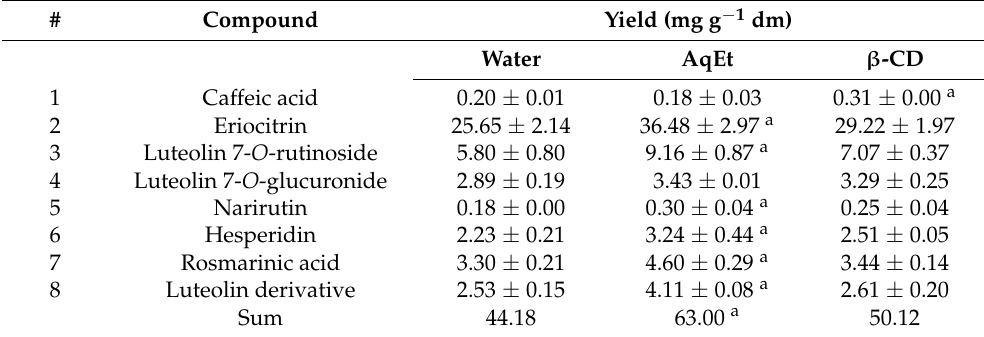
Table 5. Analytical polyphenolic profile of the extracts obtained with β -CD and the control solvents. AqEt denotes 60% aqueous ethanol. Values reported are means ± standard deviation.